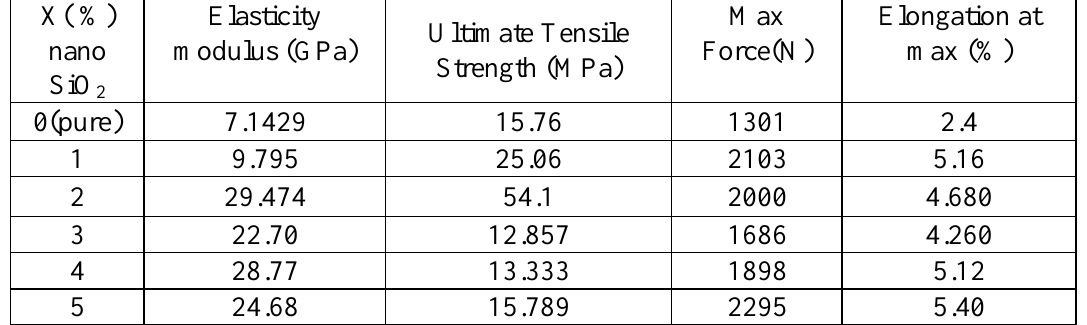
Table 3: Elasticity modulus (GPa), Tensile (MPa), Max Force (N), Elongation% and for composites (unsaturated polyester resin with filler (silica nanoparticles)).